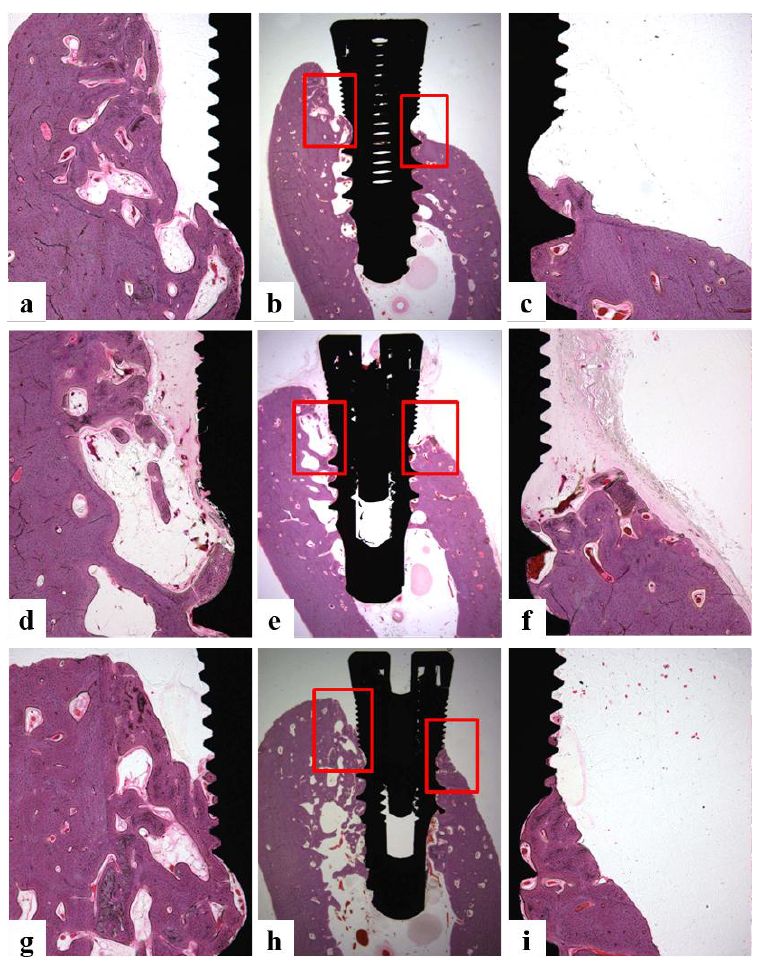
Figure 9. Microthread defect areas in the control (Ti), Hepa/Ti and PDGF/Hepa/Ti groups. Group BIC and ITBD within macrothreads at 8 weeks after surgery were not significantly different. In the control and heparin groups, vertical bone loss was detected in buccal defect areas. Failure of osseointegration in the lingual portion observed as a 1 mm gap between fixture and bone was present in the control, heparin, and PDGF groups. ( a – c ) Ti group; ( d – f ) Hepa/Ti group; ( g – i ) PDGF/Hepa/Ti group; ( a , d , g ) lingual portion of microthread; and ( c , f , i ) buccal portion of microthread. ( a , c , d , f , g , i ) ×40 magnification, ( b , e , h ) × 12.5